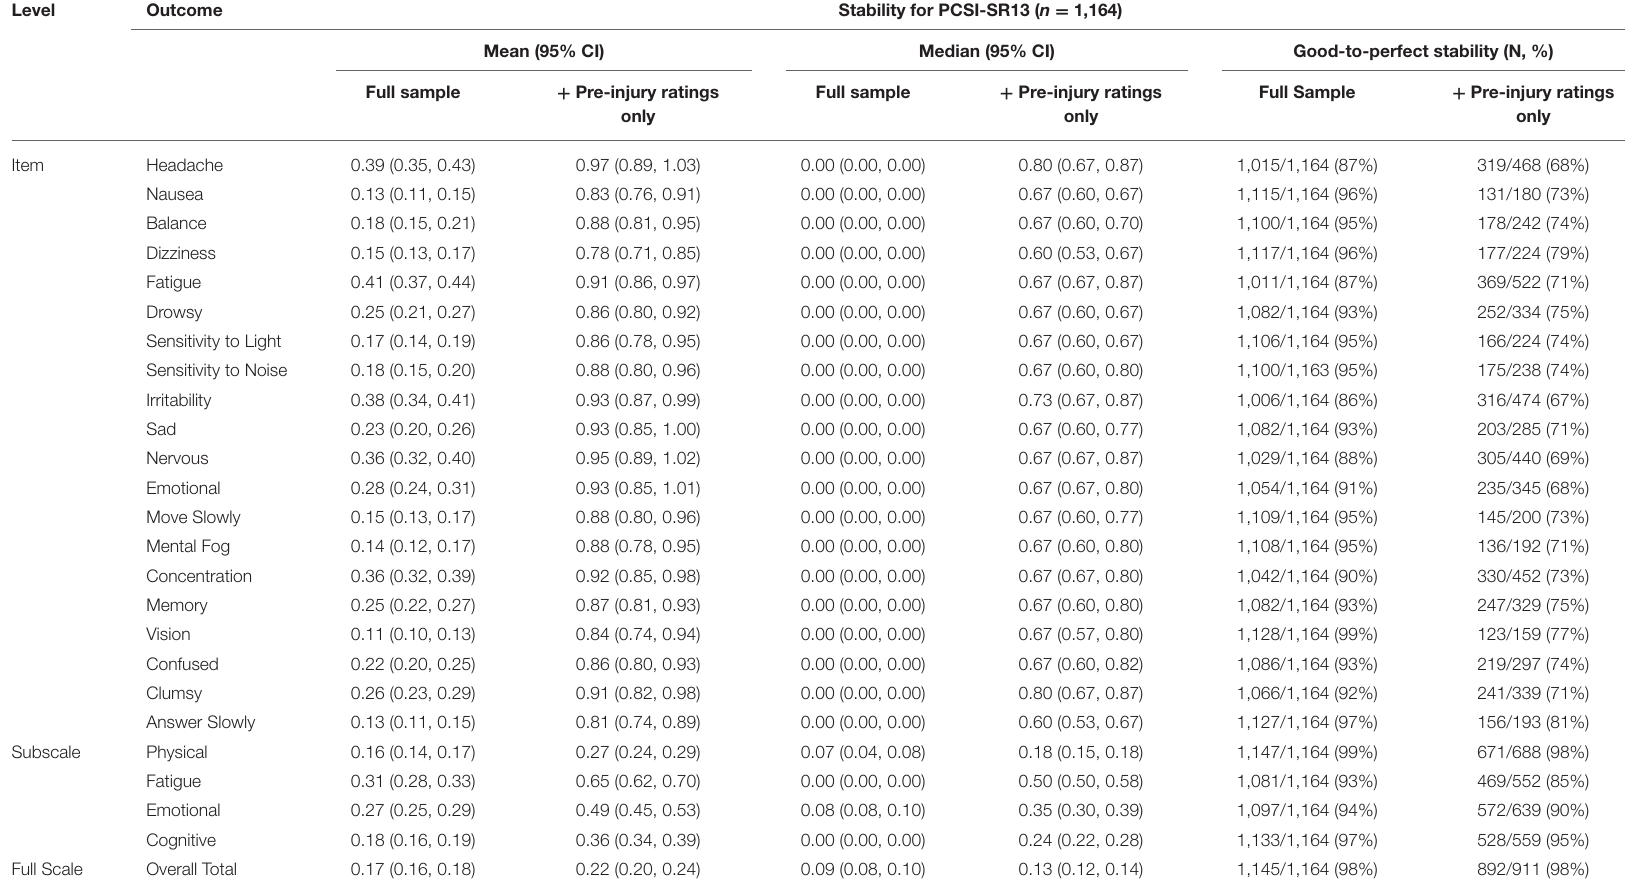
Outcomes are provided at the item, subscale, and full-scale level for the full sample and for the + Pre-Injury Ratings subgroup